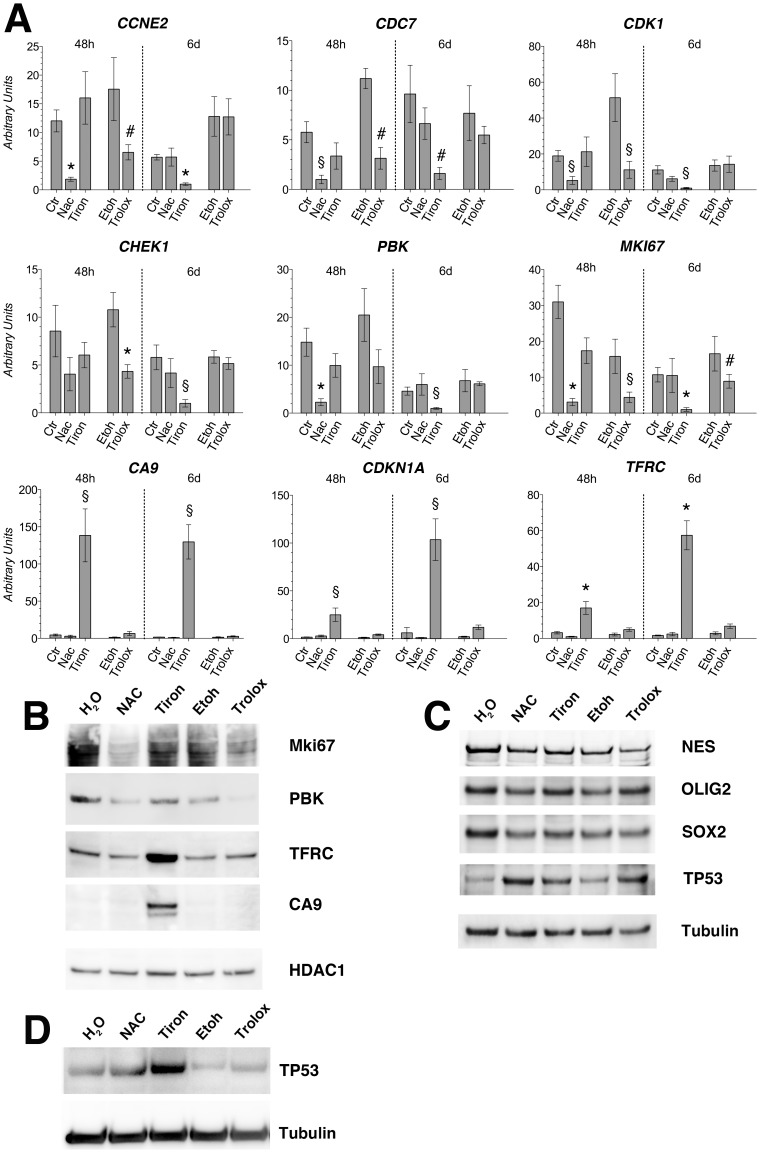
Validation of gene expression regulation by Real-time RT-PCR and Immunoblot analysis.(A) Real-Time RT-PCR analysis performed with RNA extracted from the PT4 cell culture containing GBM TICs to validate the microarray data. This was accomplished on randomly selected genes from Table S3 and showed, in arbitrary units. Expression levels are relative to the expression of the housekeeping gene transcript coding for the ribosomal protein L19 (RPL19). Standard deviations are indicated as vertical bars (n = 3 independent assays). Gene name symbols are those approved by the Human Genome Organization Gene Nomenclature Committee (http://www.genenames.org/). Standard deviations are indicated as vertical bars (n = 3 independent assays). #The unpaired t-test was significant at P<0.05. §The unpaired t-test was significant at P<0.01. *The unpaired t-test was significant at P<0.001. (B) Western blot analyses were performed with lysates of the PT4 cell culture containing GBM TICs treated for 48 h with the indicated antioxidant drug and challenged with anti MKi67, Pdz-binding kinase (PBK), transferrin receptor (TFRC), carbonic anhydrase 9 (CA9). (C) Western blot analyses were performed with lysates of the PT4 cell culture containing GBM TICs treated for 6 days with the indicated antioxidant drug and challenged with anti nestin (NES), oligodendrocyte transcription factor 2 (OLIG2), SRY (sex determining region Y)-box 2 (SOX2) and tumor protein 53 (TP53) antibodies. (D) Western blot analyses were performed with lysates of the PT4 cell culture containing GBM TICs treated for 48 h with the indicated antioxidant drug and challenged with anti tumor protein 53 (TP53) mAb. (B–D) Immunoblotted membranes were subjected to multiple antibody challenging, stripping, control of effective stripping, and re-challenging with a different antibody. The last antibody used was an anti histone deacetylase 1 (HDAC1) (B) or an anti tubulin alpha (D) to show equal loading.